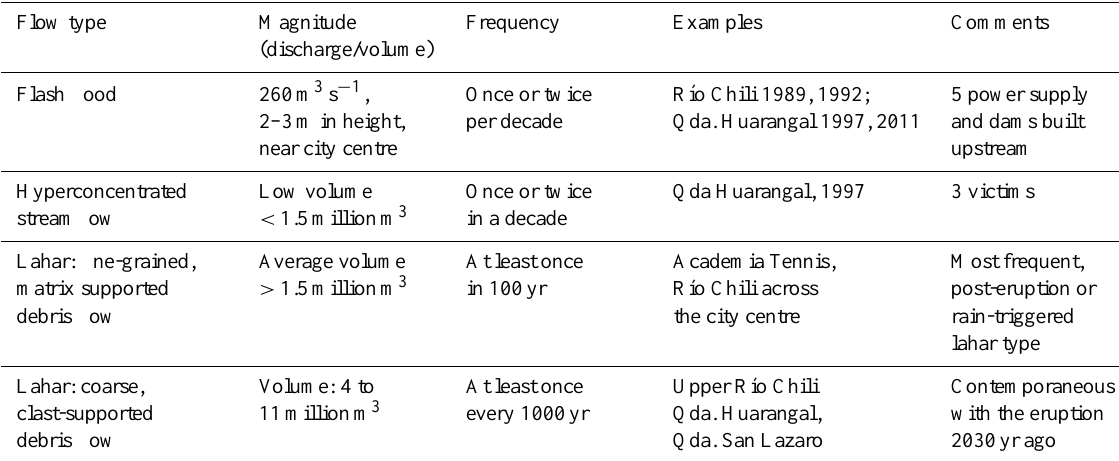
Table 1. Characteristics of lahars and flash floods in the city of Arequipa (after Martelli, 2011; Vargas-Franco et al., 2010; Delaite et al., 2005; and Thouret et al.,